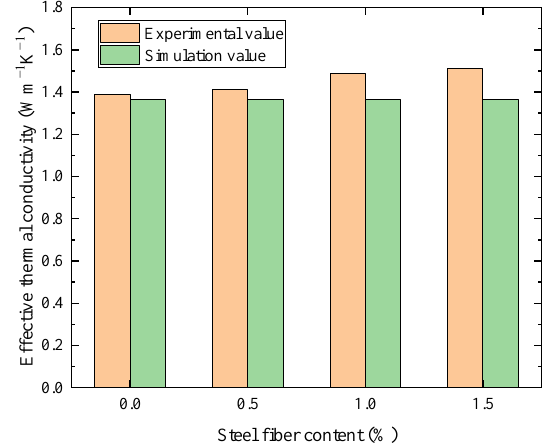
Figure 15. Effect of steel fiber content.